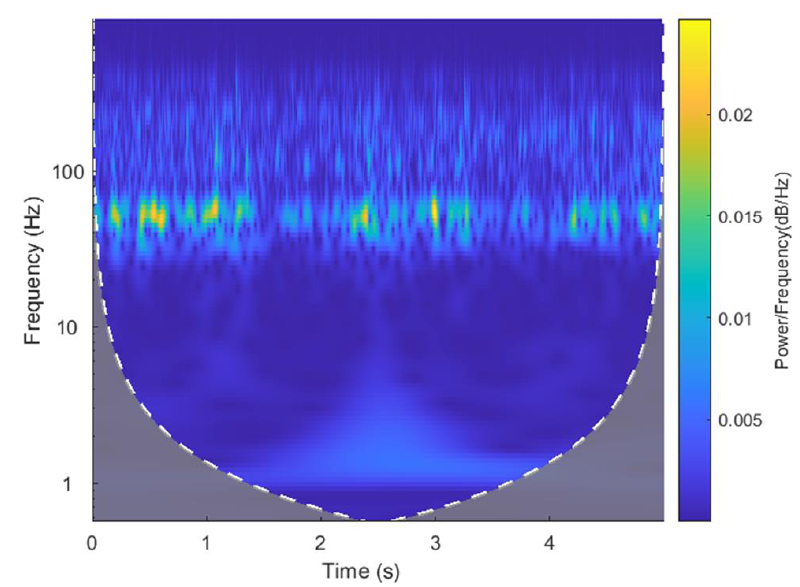
Figure 12. Wavelet-transformed time-frequency image of the predicted value from Channel 7.